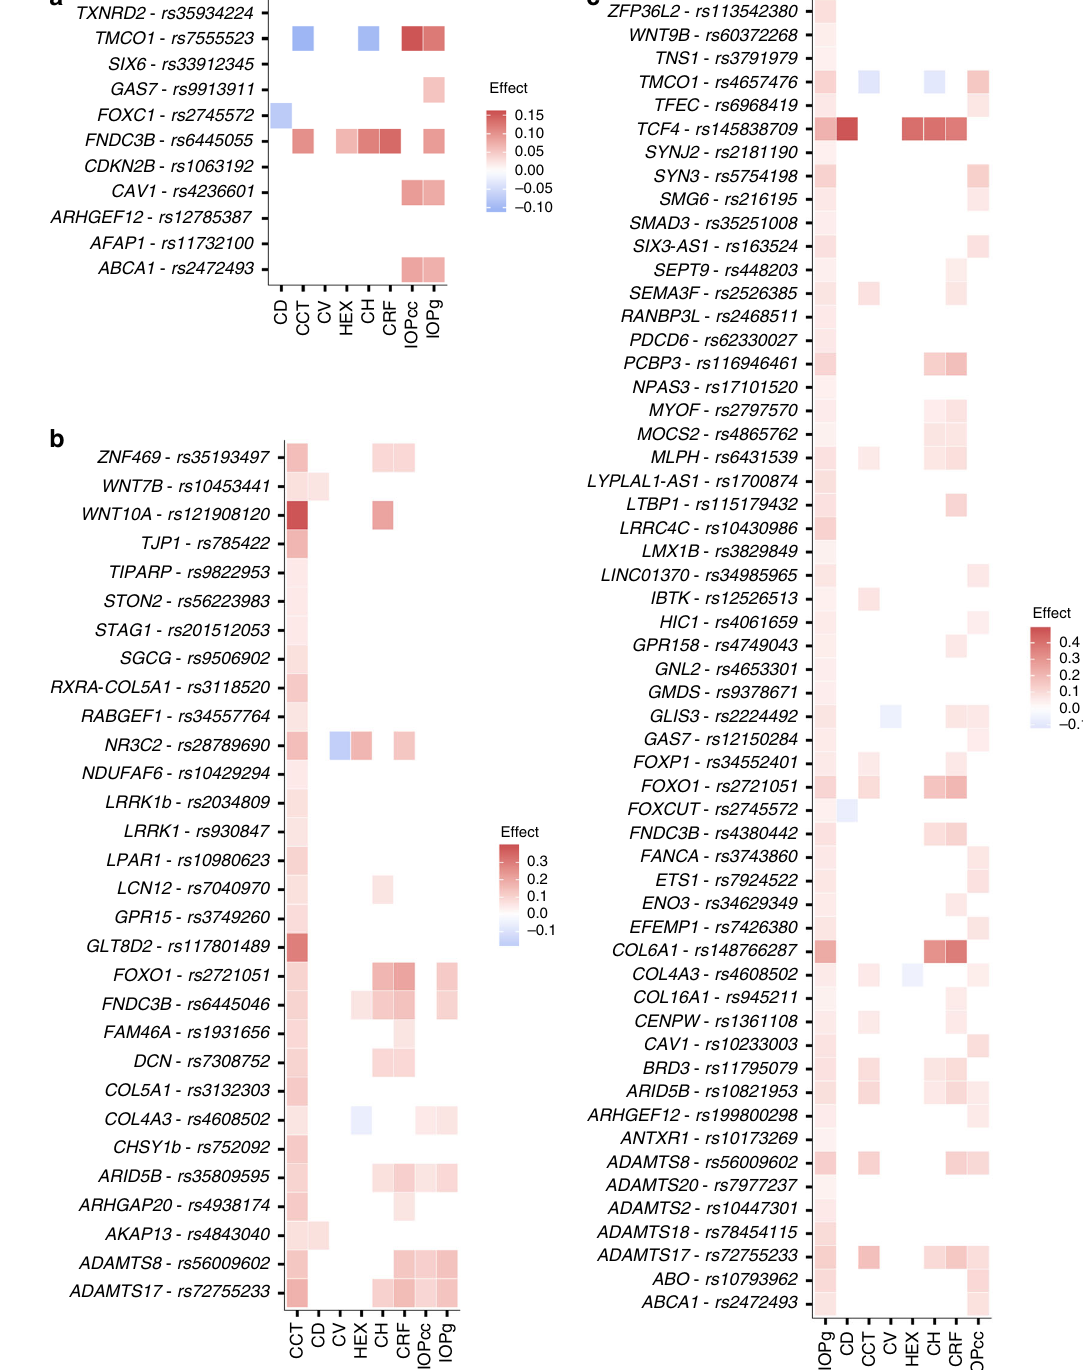
Fig. 4 The effect of reported POAG, CCT, and IOP variants on corneal measures. Red color represents a positive effect on the corneal measures and blue color represents a negative effect. a Effect of previously reported POAG variants on corneal traits for the POAG risk increasing allele. Effects on the traits are shown for signi fi cant associations after adjusting for multiple testing with a false discovery rate procedure for each variant. b Effect of previously reported CCT variants that replicate in our data ( P < 0.05) and novel CCT variants on corneal measures for the CCT increasing allele. Effects on other traits are shown for signi fi cant associations after adjusting for multiple testing with a false discovery rate procedure for each variant. c Effect of previously reported IOPg variants that replicate in our data ( P < 0.05) on corneal measures for the IOPg increasing allele. Effects on other traits are shown for signi fi cant associations after adjusting for multiple testing with a false discovery rate procedure for each